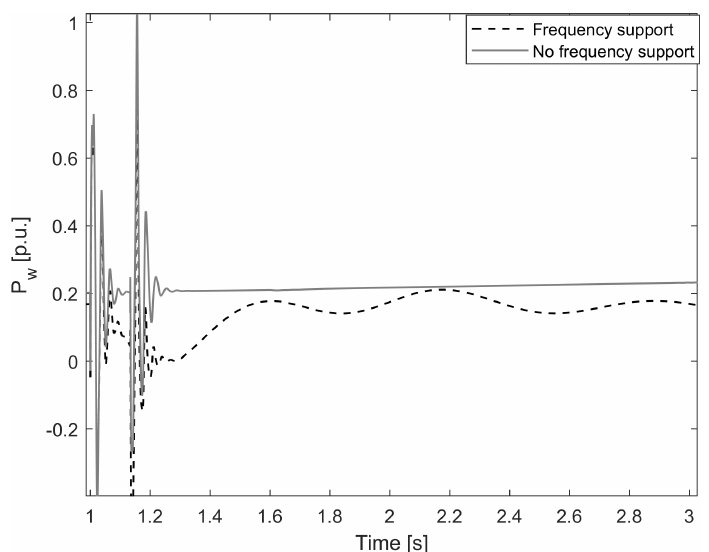
Figure 12. Active power from the wind farm with and without primary frequency